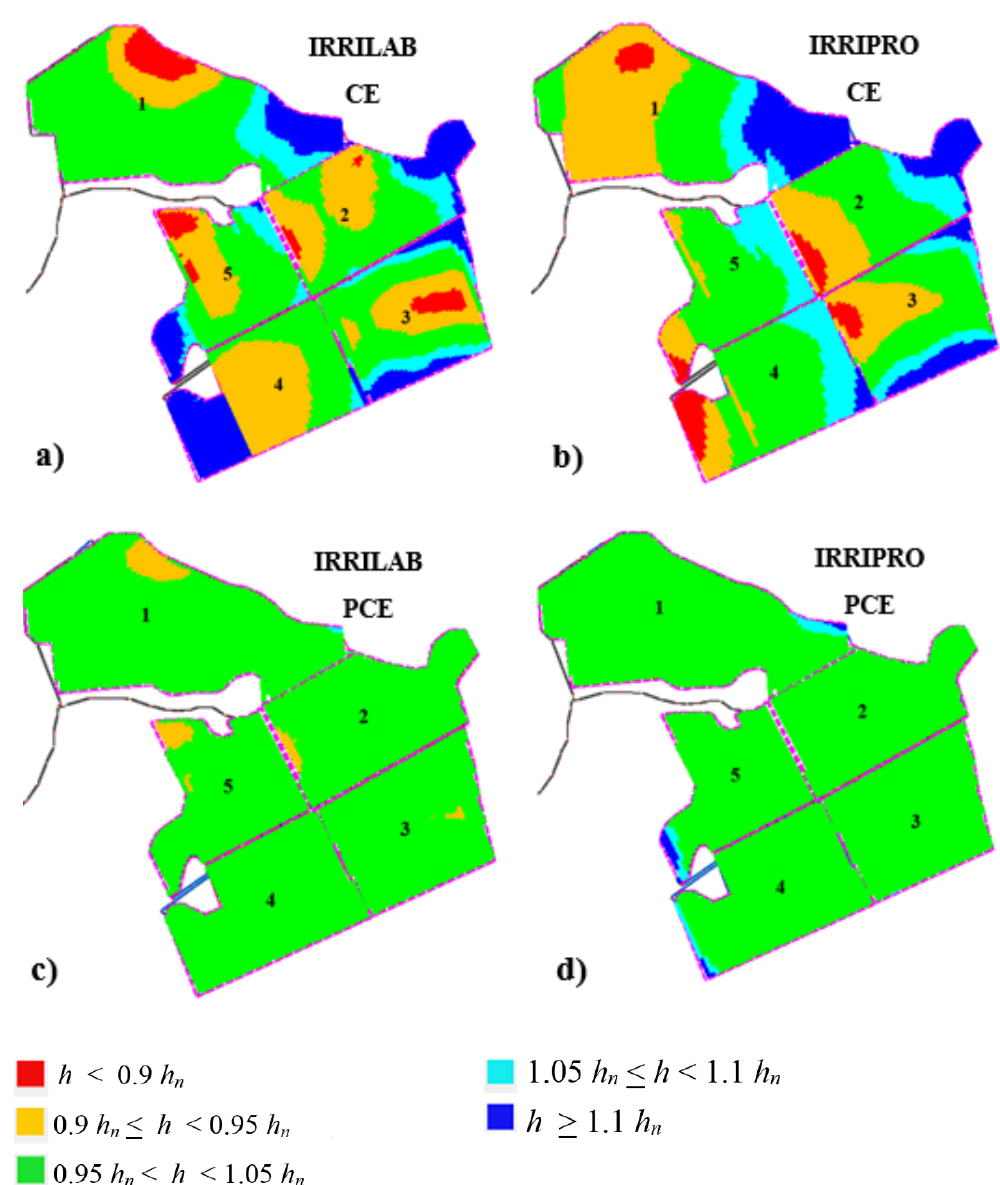
Figure 5. Emitters’ pressure head distribution maps, pertaining to the design parameters of IRRILAB ( a , c ) and IRRIPRO ( b , d ) software applications, for the actual “non-uniform” five sectors of the apple farm, in case of using common emitters (CE) ( a , b ) and pressure compensating emitters (PCE) ( c , d ).